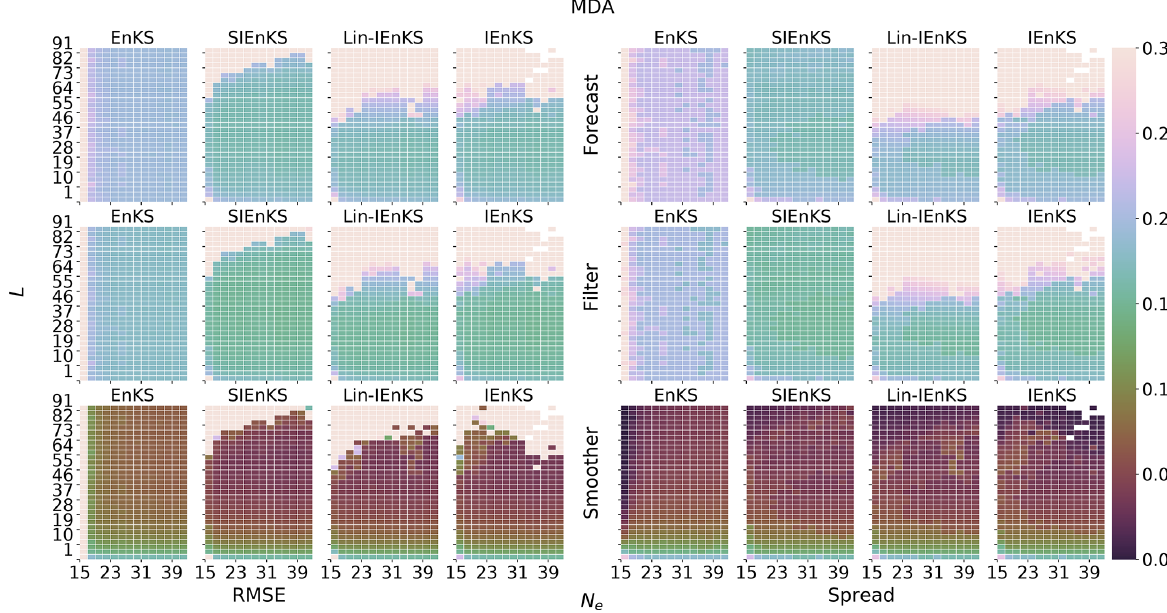
Figure 10. The lag length L is shown on the vertical axis, and the ensemble size N e is shown on the horizontal axis. MDA, tuned inflation, shift S = 1, linear observations, and (cid:49)t = 0 . 05 are indicated. The EnKS SDA results are presented here for reference.